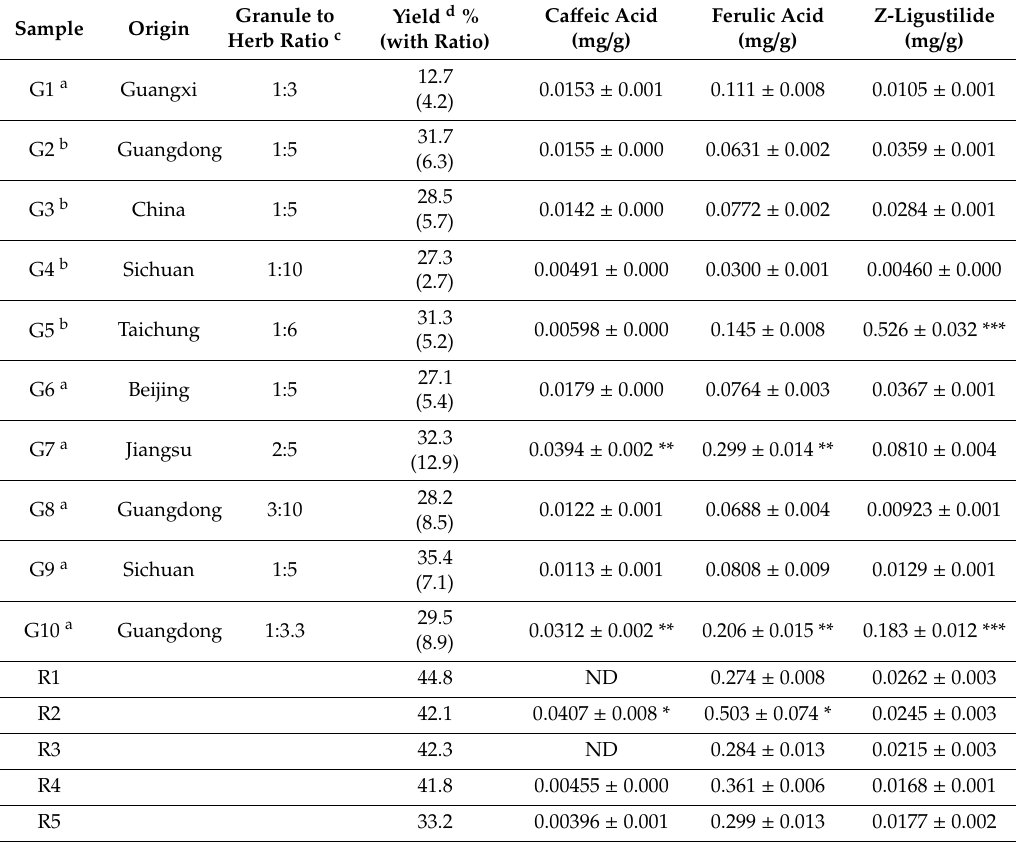
Table 1. Average contents (mg / g, means ± SD, n = 3) of the chemical markers in the ten Danggui granule samples (G1–G10) and the five herb / decoction piece samples (R1–R5) analysed by